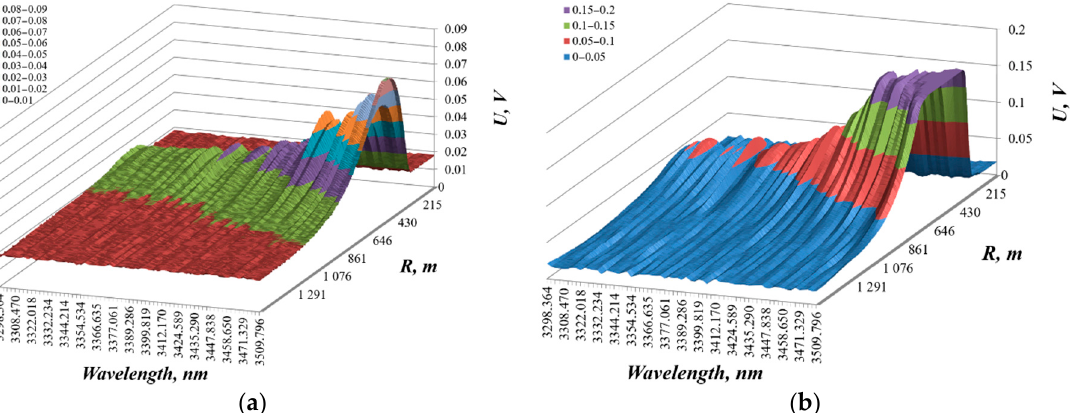
Figure 7. Tuning range for atmospheric response in the 3298–3498-nm range (amplificationn factor is equal to 1 ( a ) and 10 ( b )).